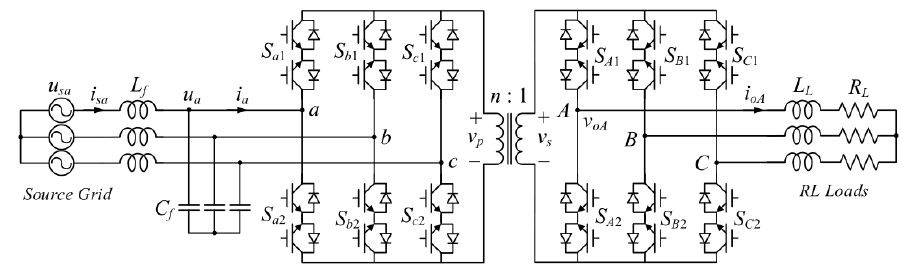
Figure 1. AC/AC matrix-converter-based SST topology adopted in [24].